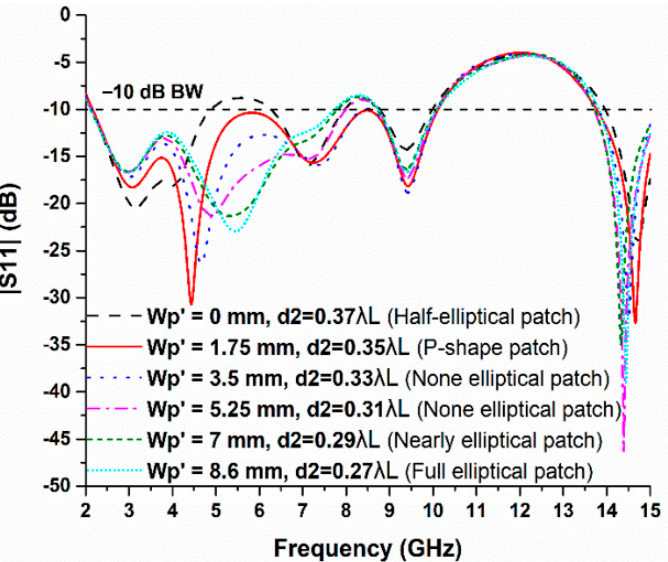
Figure 5. Study of patch dimension change of a UWB antenna array on the reflection coefficient and bandwidth.